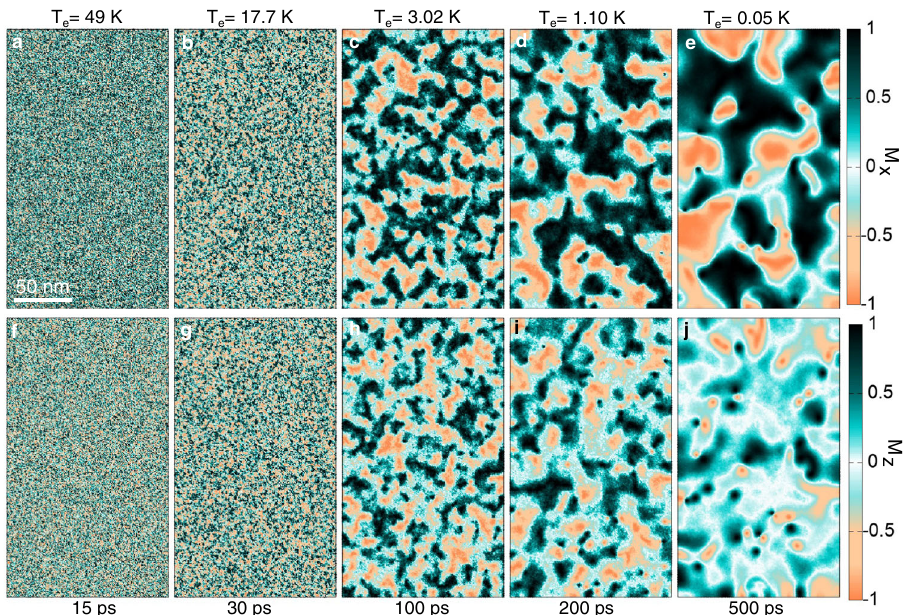
Fig. 2 Magnetic evolution after laser pulse. a-e Snapshots of the spin dynamics on the in-plane component M x at different time steps (ps) and electronic temperature T e (K) of monolayer CrCl 3 . f – j Similar as ( a – f ), for M z . The small circular dark/bright spots correspond to the emergence of vortices and antivortices with the laser excitation.